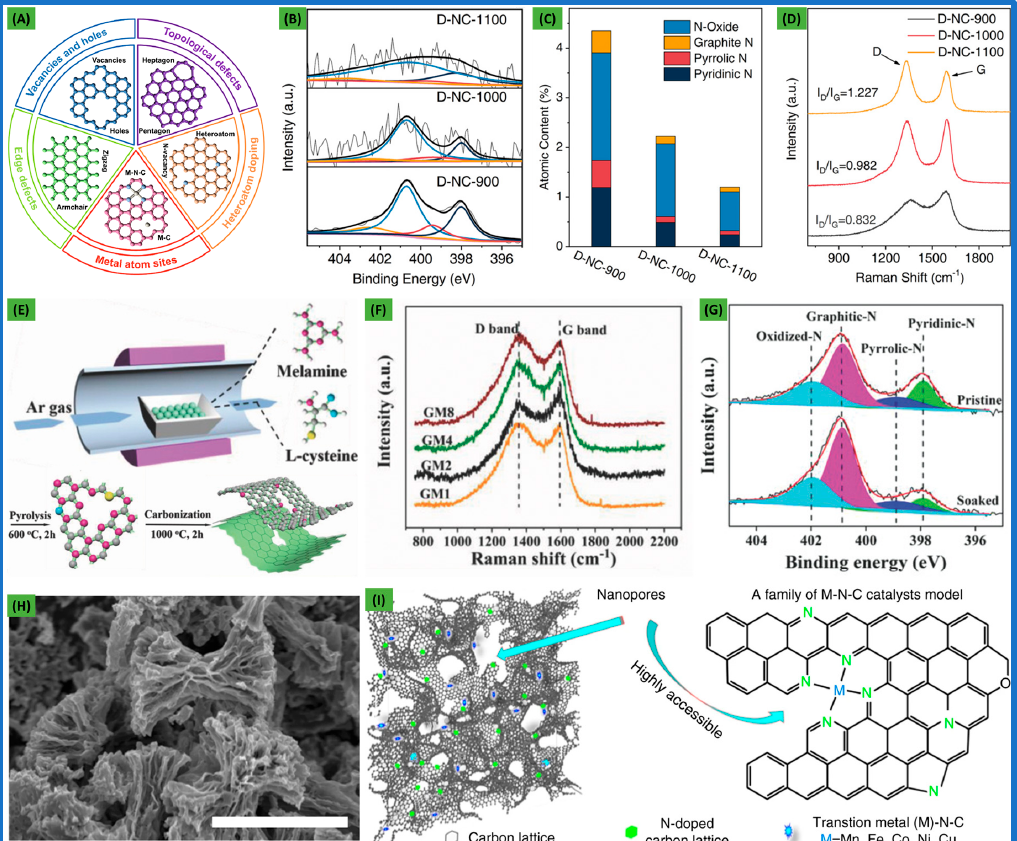
Figure 9. Schematic illustration of distinct types of defective CBN ( A ) [207]; XPS N1s spectra ( B ), N content ( C ), and Raman spectra ( D ) of intrinsic-defect engineered D-NC-X electrocatalyst [238]; synthesis process ( E ), Raman spectra ( F ), and N1s XPS spectra ( G ) of nitrogen-doped GM-X electrocatalysts [239]; typical SEM image ( H ) and material model and local schematic structure ( I ) of N-coordinated metal-doped (M-N-C) electrocatalysts [240].